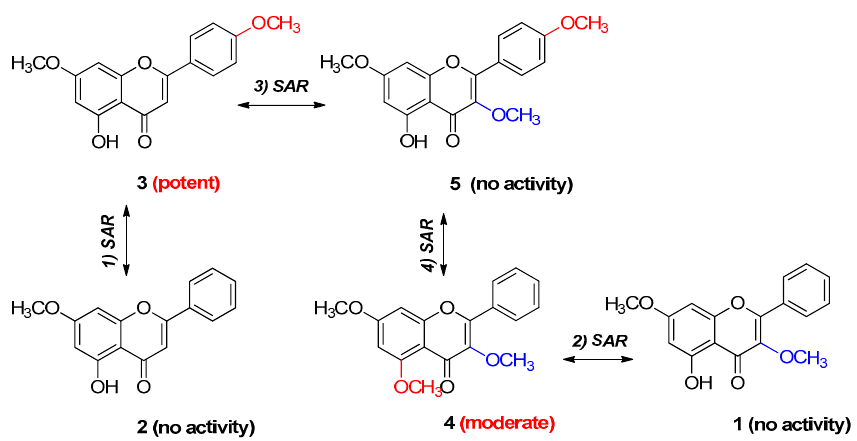
Figure 6. Key structural elements (positive element—red; negative element—blue) influencing anti- melanogenic activity and structure–activity relationships (SARs) among the isolated methoxyfla- vones.